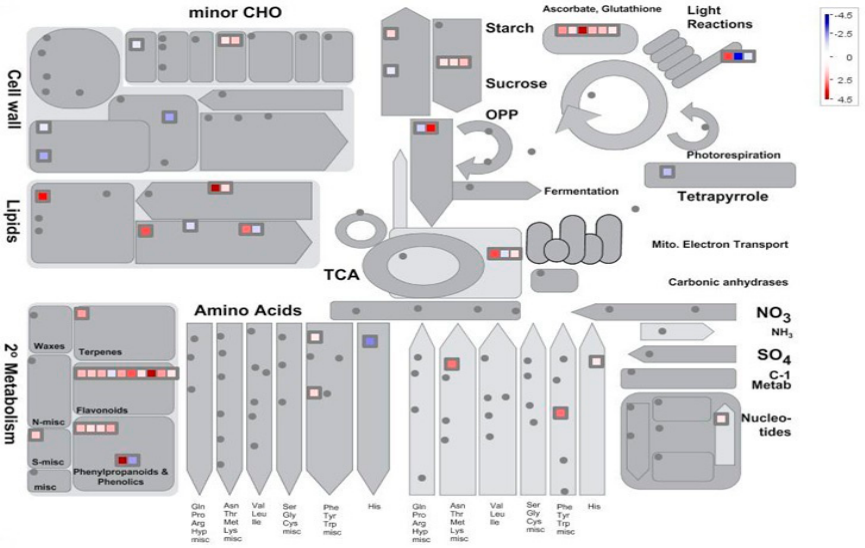
Figure 5. Differentially expressed gene function enrichment analysis after NaCl treatment.